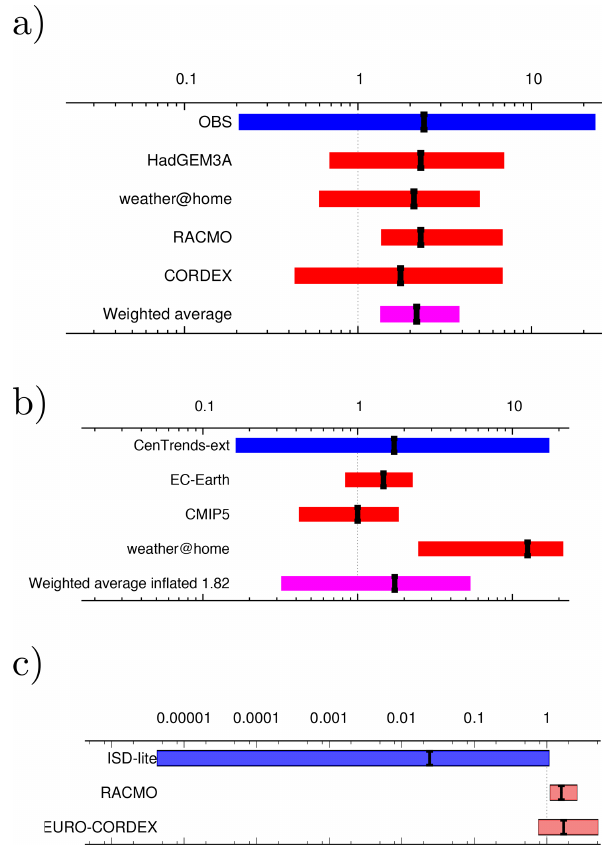
Figure 9. Synthesis plots of (a) the PR of extreme 3-day aver- aged precipitation in April–June averaged over the Seine basin (Philip et al., 2018b), (b) the PR of low precipitation in February– September in Ethiopia (8–13 ◦ N, 38–43 ◦ E) with inflated average (Philip et al., 2018c), and (c) the PR for changes in wind intensity over the region of storm Friederike on 18 January 2018 (after Vau- tard et al., 2019). Observations are shown in blue, models in red, and the average in